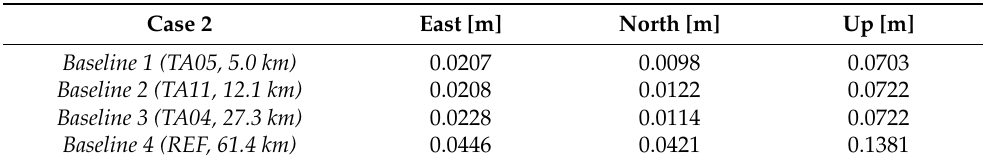
Table 7. Standard deviation in the east, north, and up directions from the true coordinates of the rover station during the jamming incident of Case 2. Calculated for all baseline solutions in using a combined GPS + Galileo solution on L1 + L2. Case 2 East